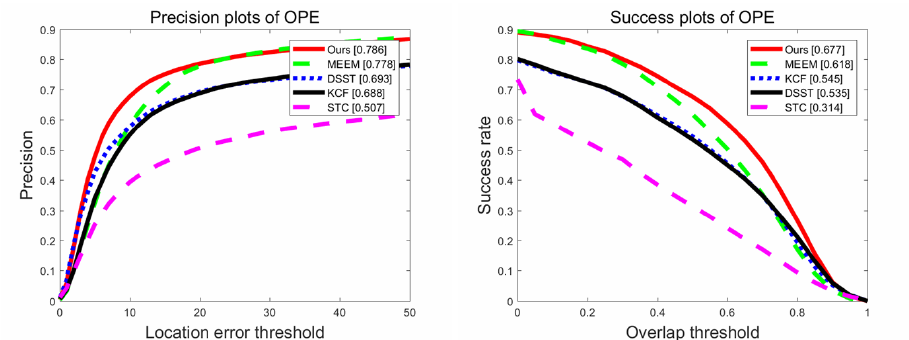
Figure 4. Precision and success plots over all sequences using OPE on the OTB100 dataset. The average score on DP at 20 pixels for each tracker is shown in the legend of the precision plot. The legend of the success plot contains the area-under-the-curve (AUC) score for each tracker.